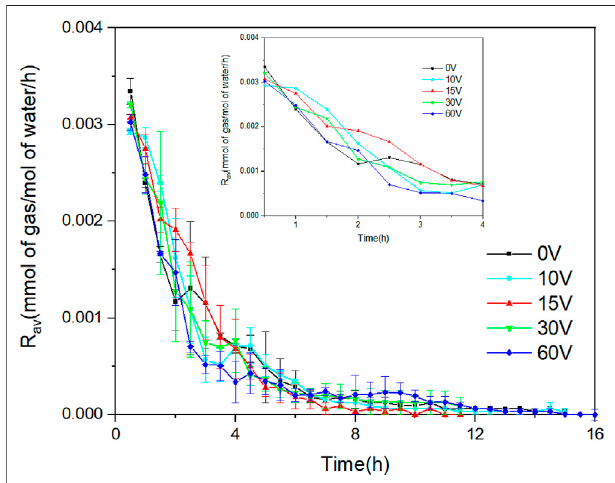
FIGURE 8 | The average rate of hydrate formation in the application of different voltages at 3.5 MPa and 274.15 K